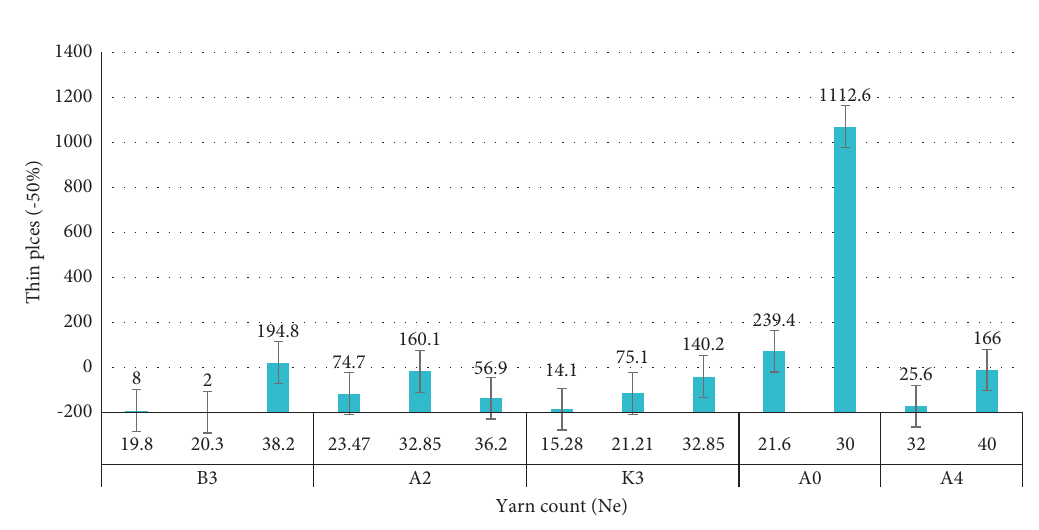
Figure 2: Yarn thin place ( −